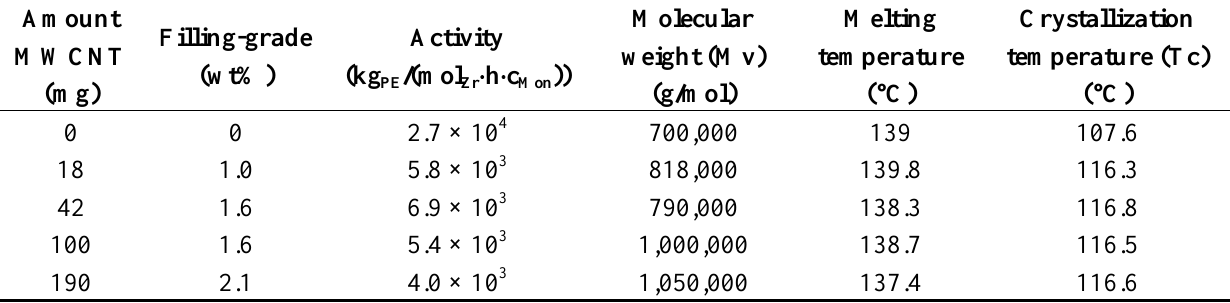
Table 6. Polymerization activity and polymer properties of polyethylene/ multiwalled carbon nanotube (MWCNT)